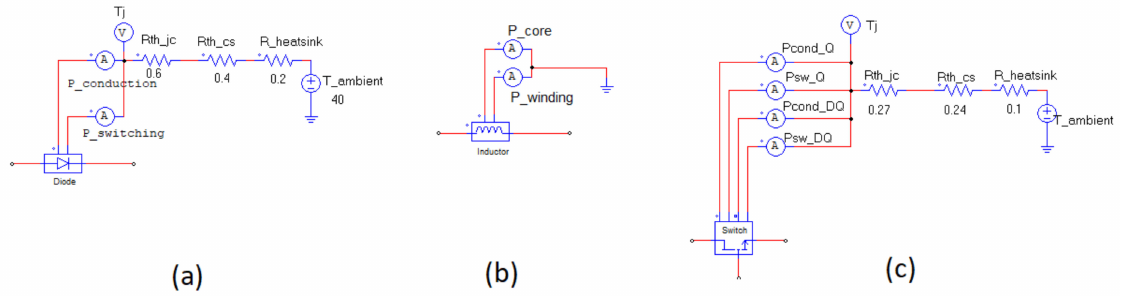
Figure 13. Equivalent circuits in PSIM thermal module for ( a ) diode, ( b ). inductor, ( c ).